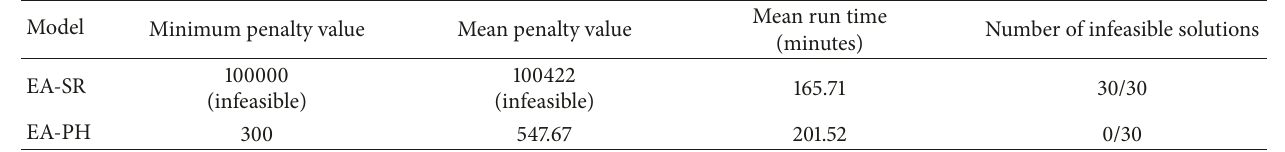
Algorithm 3: Power Mutation algorithm [22]. Table 4: Performance of both models based on penalty value with different initialization procedures.